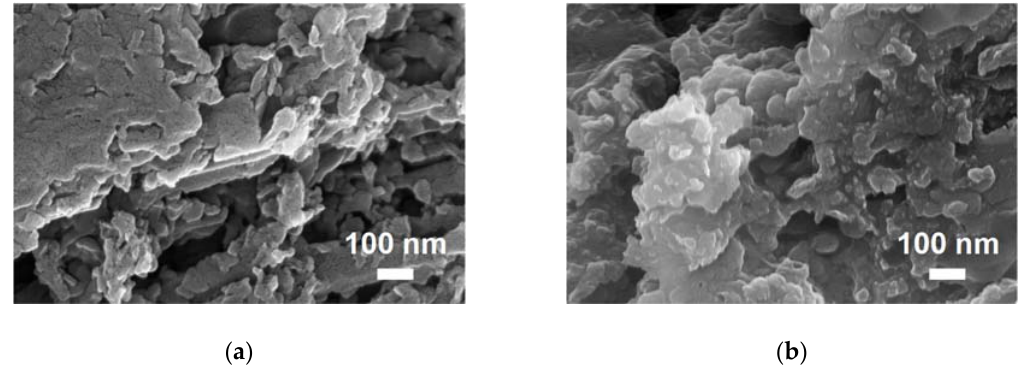
Figure 1. FE ‐ SEM images of ( a ) bulk g ‐ C 3 N 4 and ( b ) electrochemically activated g ‐ C 3 N 4 nanosheets.